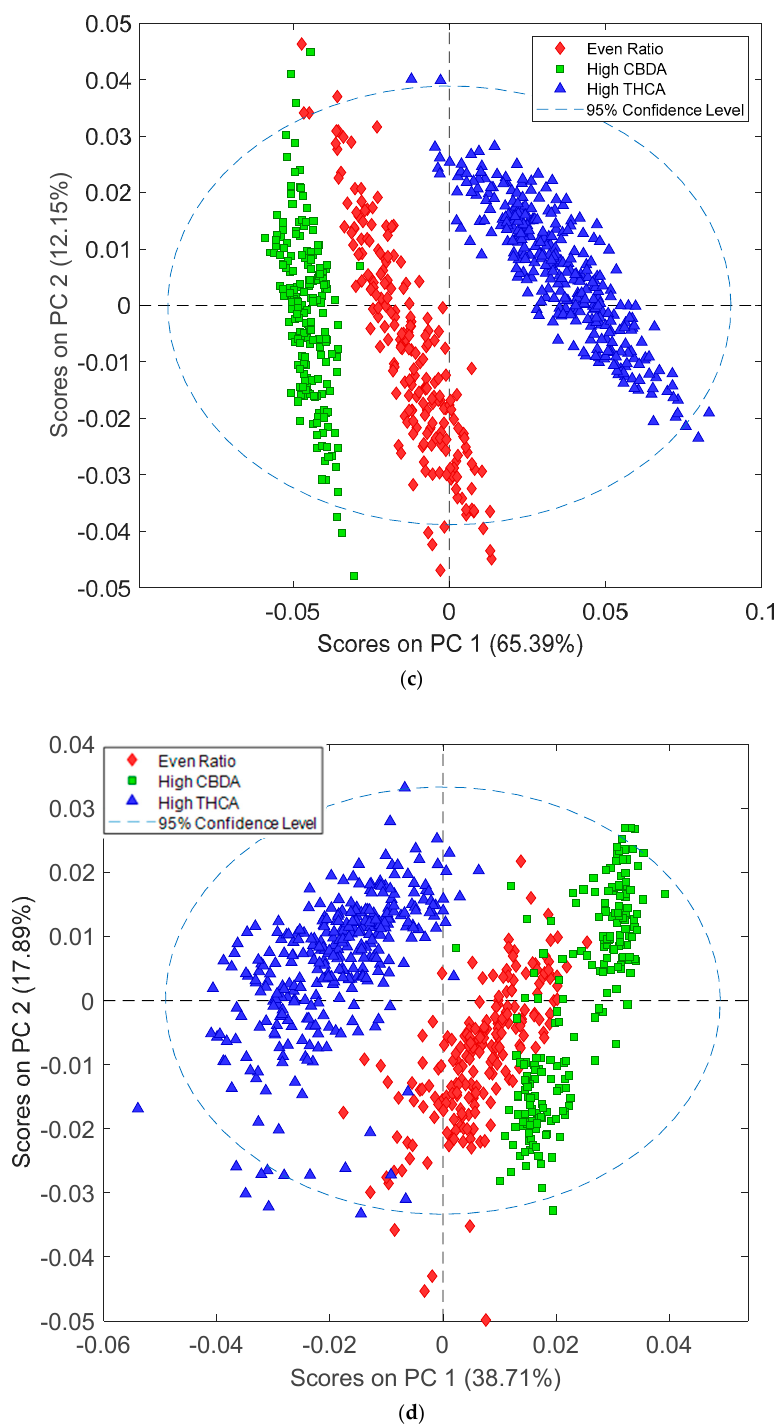
Figure 1. ( a ) Near-infrared spectra of all samples using the Bruker MPA II FT-NIR spectrometer in the 9000 cm − 1 to 4000 cm − 1 range. Green line: high CBDA; blue line: high THCA; red line: even ratio. ( b ) Near-infrared spectra of all samples using the handheld VIAVI MicroNIR Onsite-W in the 950 nm to 1650 nm range. Green line: high CBDA; blue line: high THCA; red line: even ratio. ( c ) Scores plot of two principal components of the entire cannabis sample set (averaged data, n = 734) using the Bruker MPA II FT-NIR spectrometer (9000 cm − 1 to 4000 cm − 1 range). The three major clusters across PC1 were assigned as high THCA (blue triangles), high CBDA (green squares) and even ratios (red diamonds). ( d ) Scores plot of two principal components of the entire